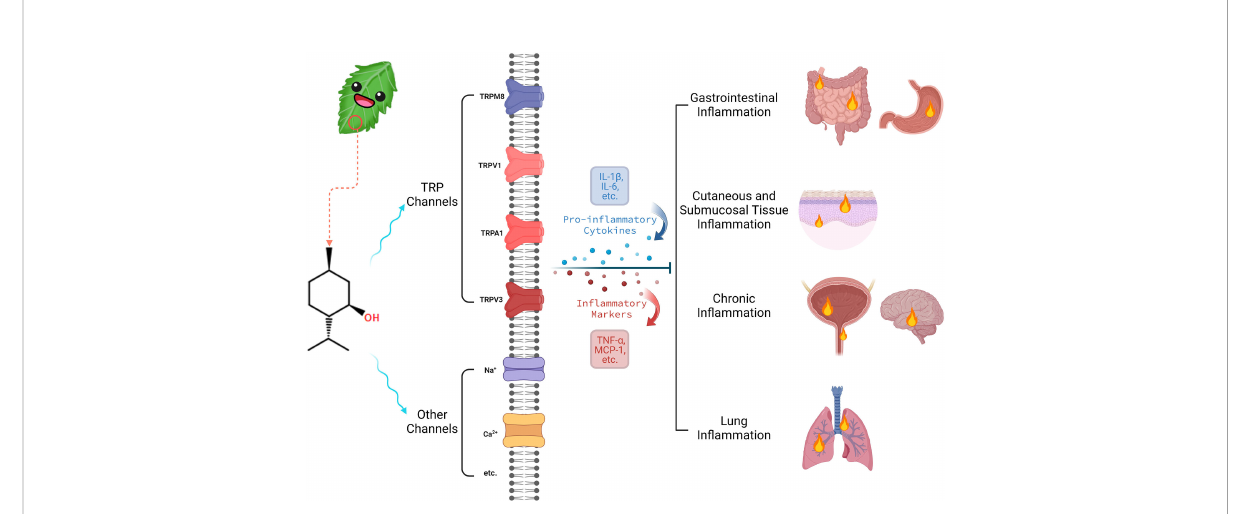
FIGURE 1 Brief overview of menthol ’ s biological activity in in fl